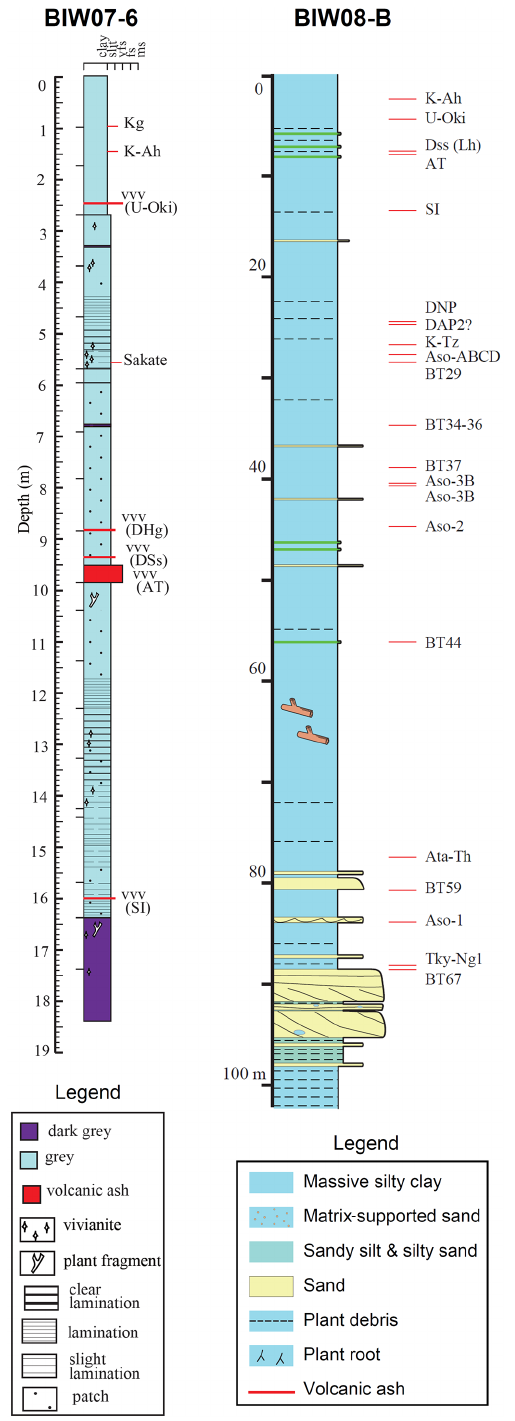
Figure 2. Lithologic columns of (a) core BIW07-6 and (b) borehole core BIW08-B (Takemura et al., 2010).